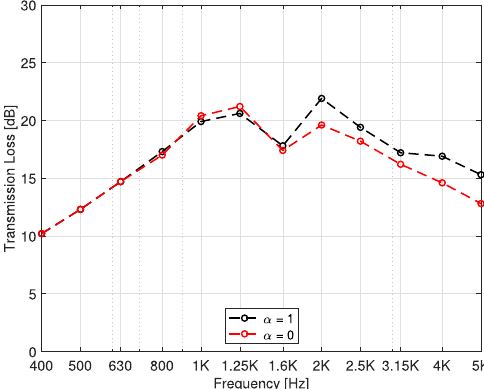
Figure 12. Illustration of a simpli fi ed HVAC duct network with fi ve acoustic